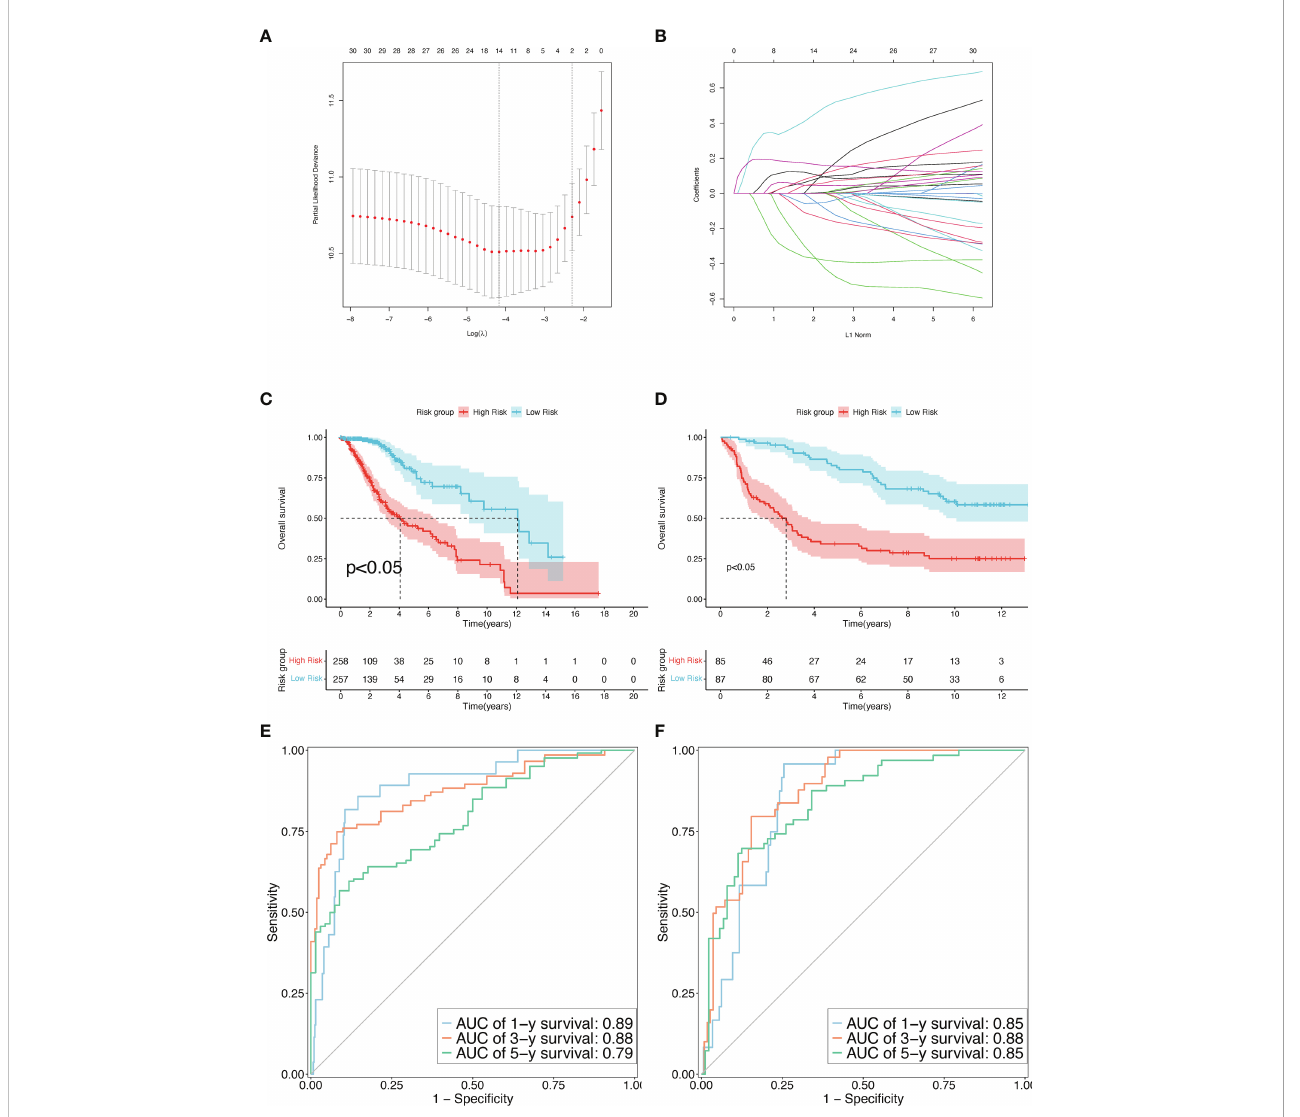
FIGURE 4 Construction and validation of the TPR signature. (A) The LASSO-Multi-Cox regression identi fi ed a bene fi cial signature via min lambda; left dash: min lambda, right dash: standard lambda. (B) Ten cross-validations for adjusting and optimizing the parameter screen out in the LASSO-Multi Cox regression. (C, D) The overall survival rate between high-risk and low - risk groups using the median risk score in the TCGA-LGG (D) and CGGA325 cohorts (E) . (E, F) Time-dependent receiver operating characteristic (tdROC) curves to determine the accuracy of the TPR signatures for predicting the mortality event of LGG patients in the TCGA-LGG (D) and CGGA325 cohorts (E)